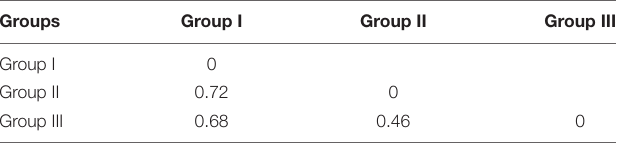
TABLE 3 | The F ST value between three groups.